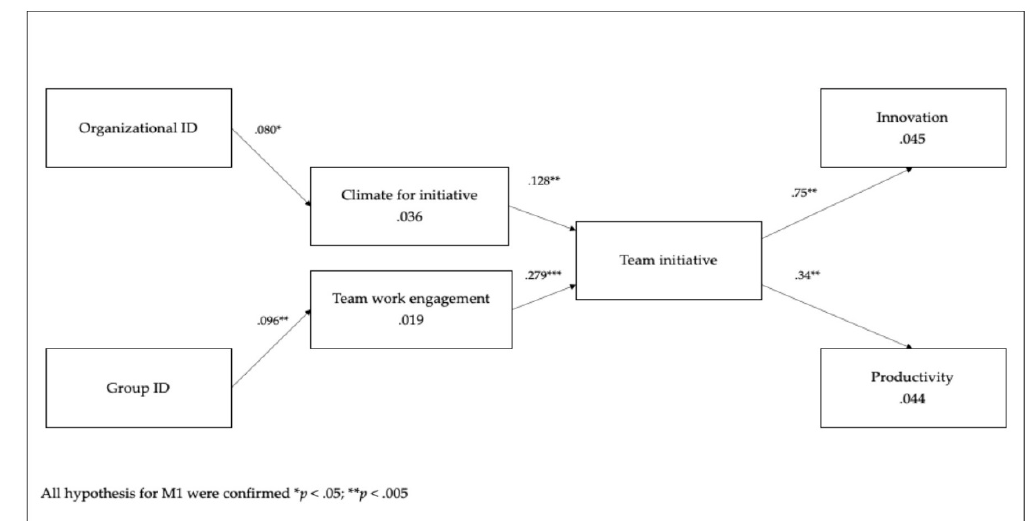
Figure 2. Path Model Figure 2. Path Table 4. Model fit.